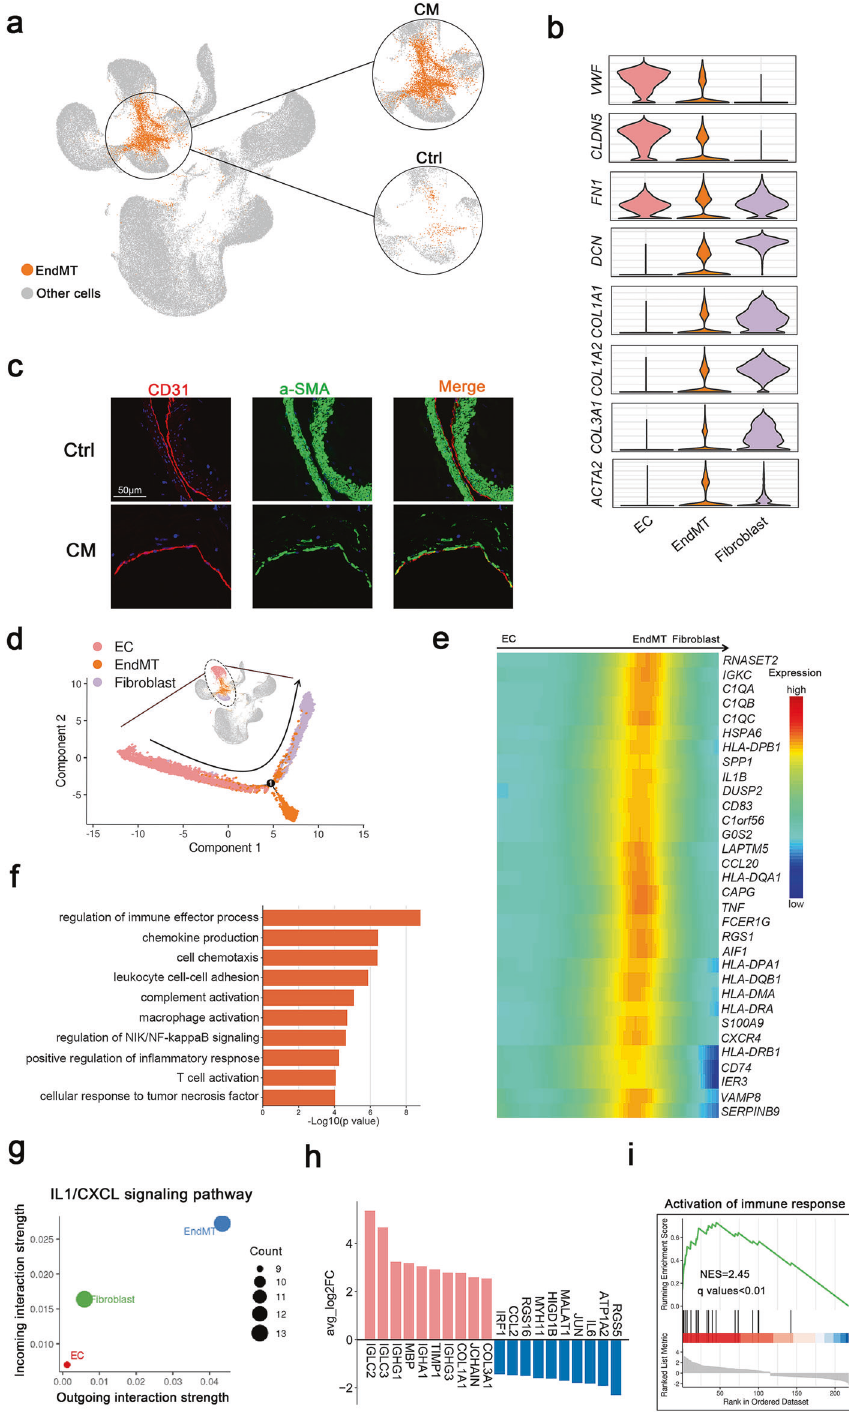
Fig. 4 Endothelial-to-mesenchymal transition cell cluster. a UMAP plot for EndMT and other cells (left panel) divided into control and CM groups (right panel). b Marker genes of ECs, EndMT cells and fi broblasts shown in violin plots. c Immuno fl uorescence staining of EndMT markers (CD31 and a-SMA) in the control and CM groups. CD31, red; a-SMA, green and DAPI-stained nuclei shown in blue. Scale bars, 50 µm. d Monocle 2 pseudotime analysis for ECs, EndMT cells and fi broblasts. e Heatmap showing the expression of dynamic immune genes along the pseudotime axis and a bar plot for Gene Ontology (GO) enrichment analysis of these genes ( f ). g Scatter plot showing outgoing ( x -axis) and incoming ( y -axis) cellular interaction strength of IL1 and CXCL signaling pathways in ECs, EndMT cells, and fi broblasts. h Top ten differentially expressed genes (DEGs) upregulated (pink, avg_log2FC ≥ 0.25 and P value < 0.05) or downregulated (blue, avg_log2FC ≤ -0.25 and P value < 0.05) in lesion EndMT cells. i Gene set enrichment analysis (GSEA) indicating the enrichment of immune activation in lesion EndMT cells based on the Molecular Signatures Database